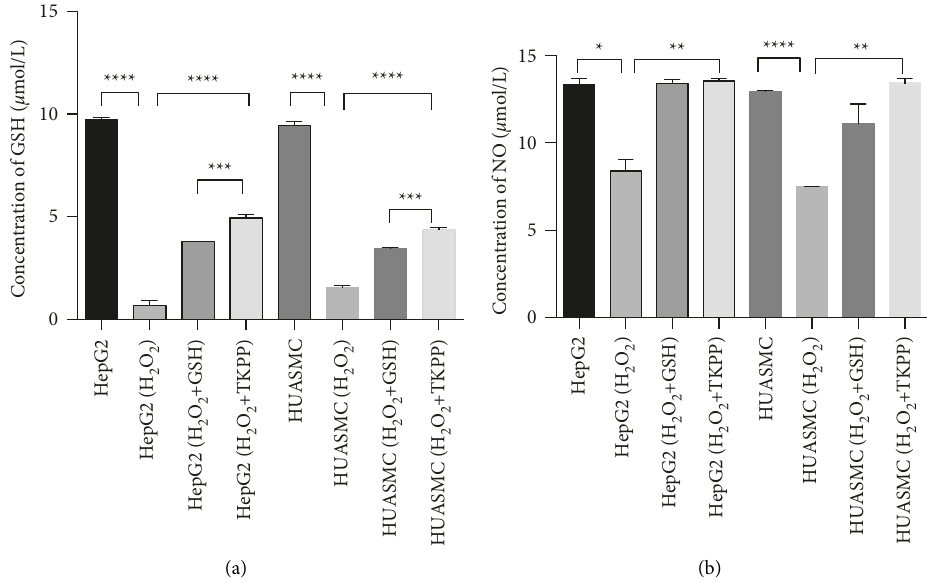
Figure 2: The expression detection of GSH and NO in different groups. (a) The level of GSH in oxidized HepG2 and HUASMC cells. (b) The NO secretion in oxidized HepG2 and HUASMC cells. ∗ P < 0 . 05, ∗∗ P < 0 . 01, ∗∗∗ P < 0 . 001, and ∗∗∗∗ P < 0 . 0001.